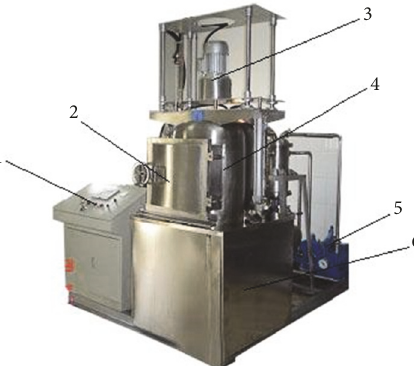
Figure 1: The vacuum frying equipment ((1) control center which controls the oil temperature, vacuum degree, frying time, deoiling speed, deoiling time, (2) the door of vacuum fryer, (3) frying basket lift and centrifugal deoiling machine, (4) frying chamber, (5) vacuum pump, (6) sandwich pot, storage oil, and steam